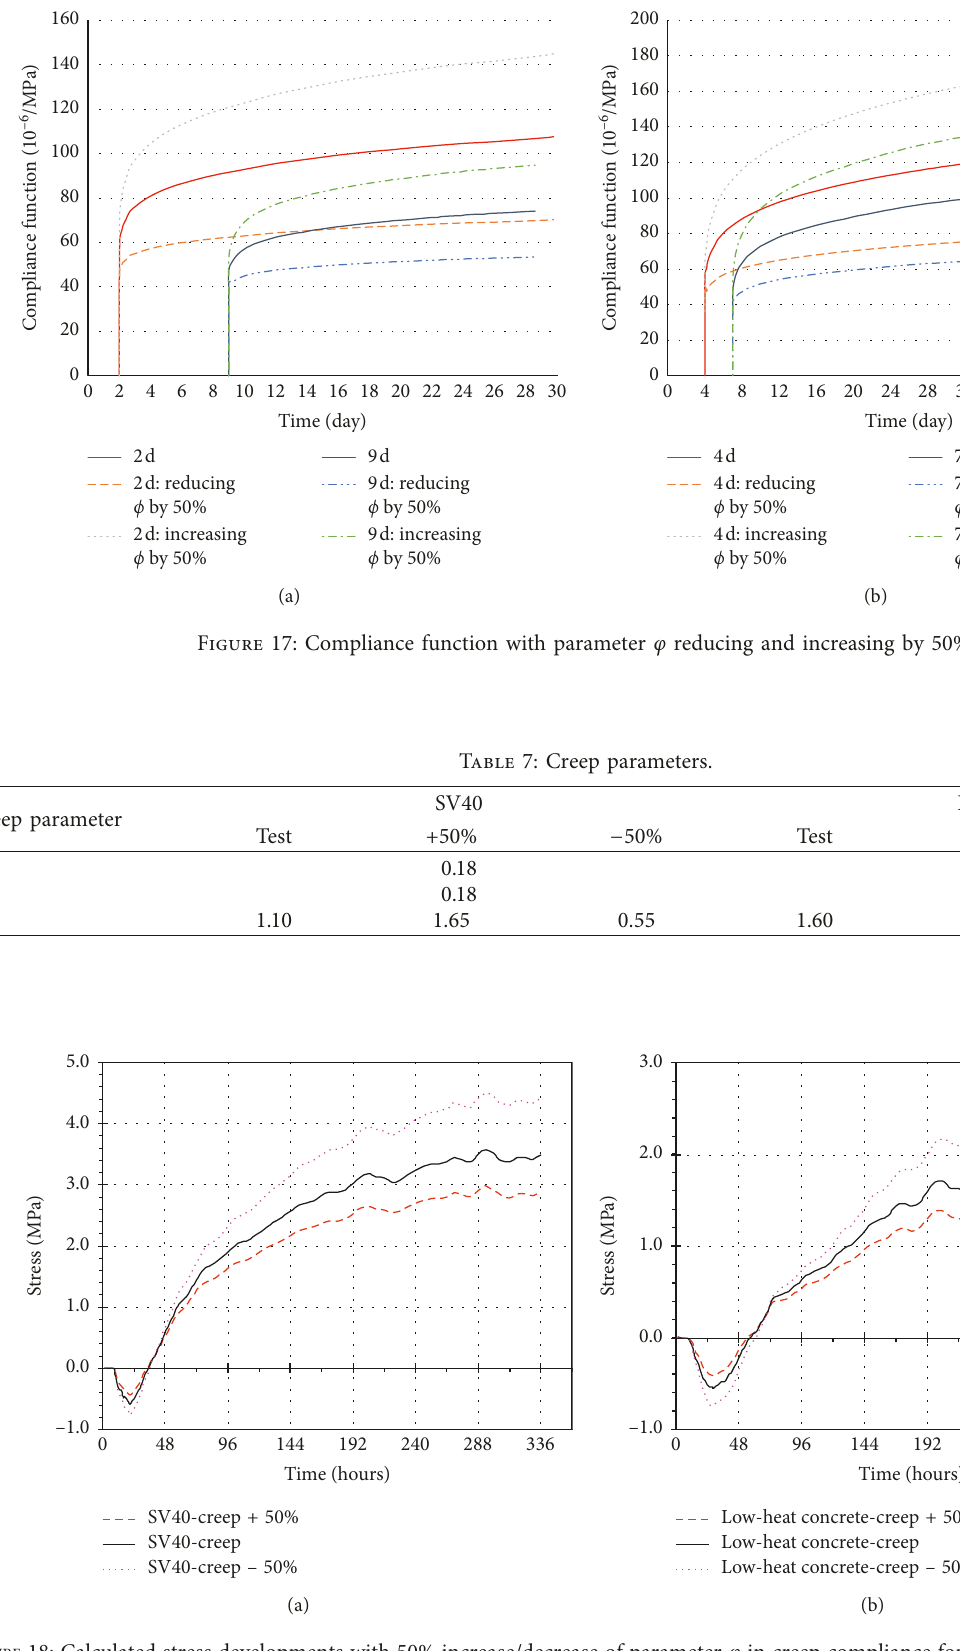
F IGURE 18: Calculated stress developments with 50% increase/decrease of parameter φ in creep compliance for (a) SV40 and (b) low-heat